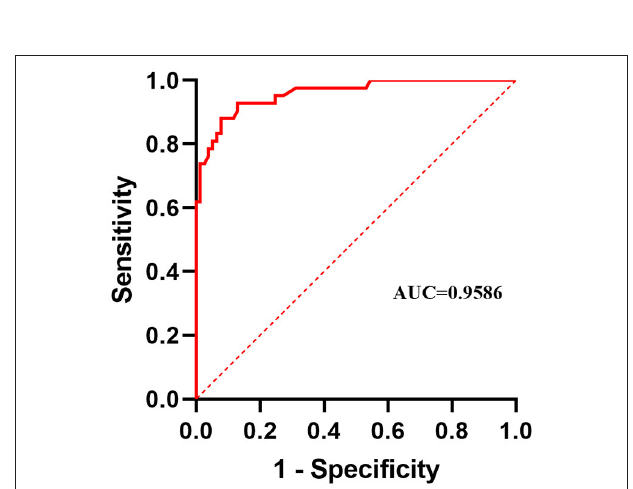
FIGURE 11 | Receiver operating characteristic